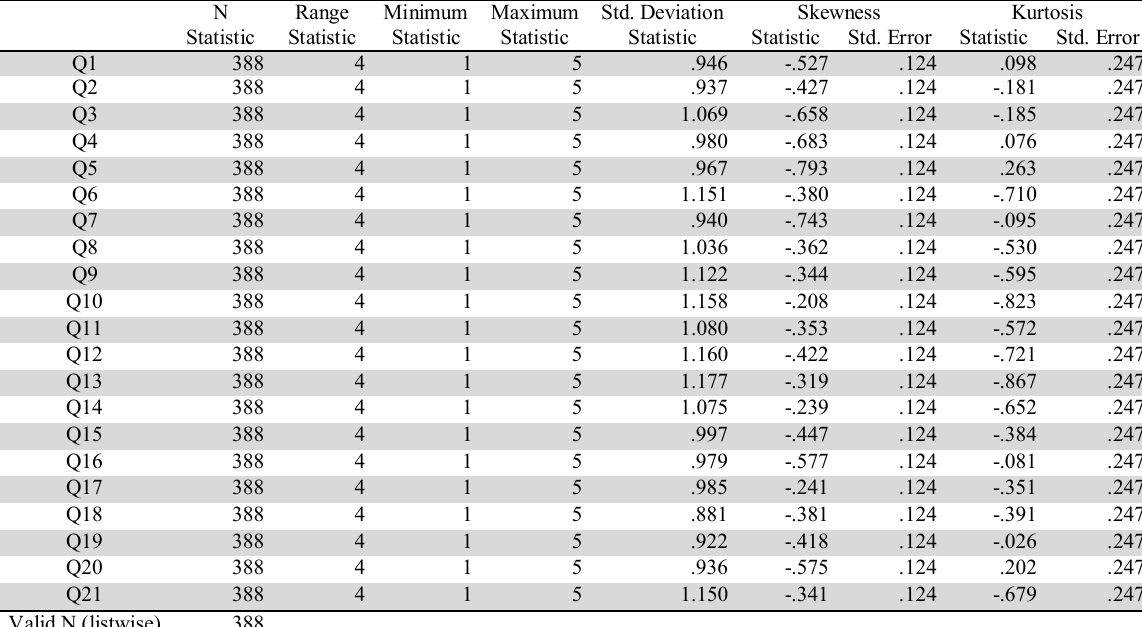
Table 1 The summary of basic descriptive statistics